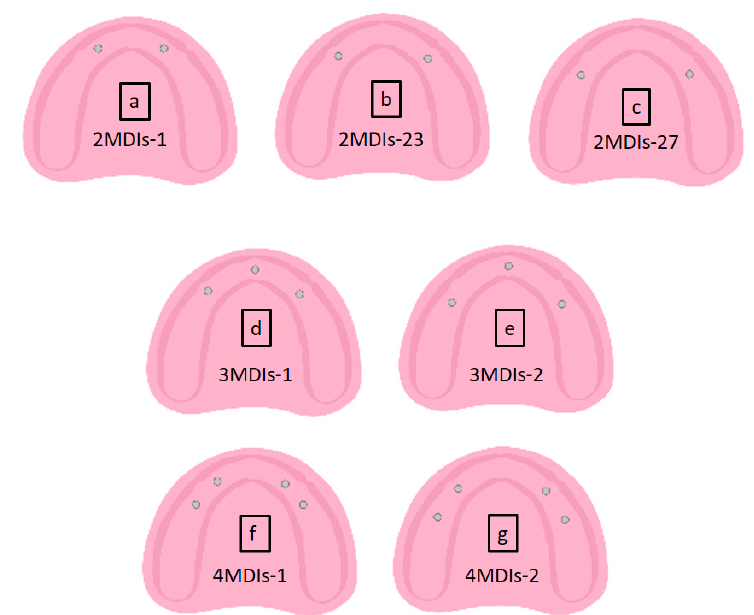
Figure 1. The MDIs were distributed according to their number into seven groups: for the two MDIs groups, ( a ) at lateral incisors area 19 mm apart (2MDIs-1), ( b ) at canine area 23 mm apart (2MDIs-23) and ( c ) at first premolar area 27 mm apart (2MDIs-27). In the three MDIs group, one MDI was placed at the midline and two MDIs were arranged ( d ) at the canine area (3MDIs-1) or ( e ) at the premolar area (3MDIs-2). The four MDIs group was distributed in 2 arrangements; ( f ) 2 posterior MDIs placed at the first premolars area and 2 anterior MDIs placed at the area of the lateral incisors (4MDIs-1), and ( g ) 2 posterior MDIs placed at the second premolars area and 2 anterior MDIs placed at the canines area (4MDIs-2).